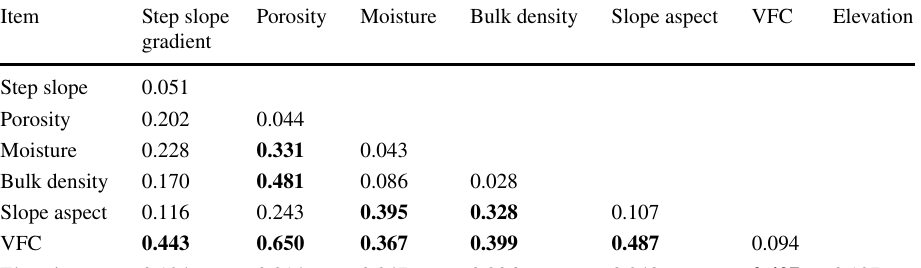
Table 4 Results of the interaction detector